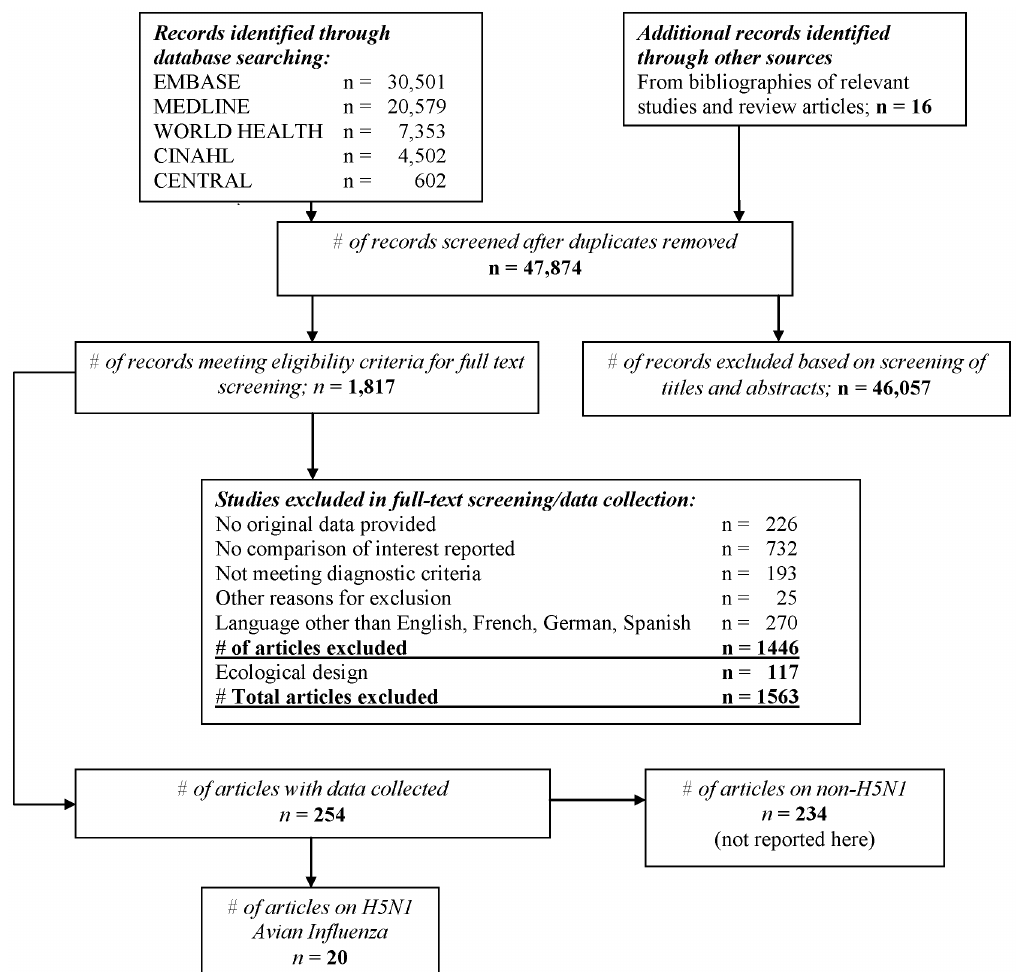
Figure 1. Flow diagram of included and excluded studies.